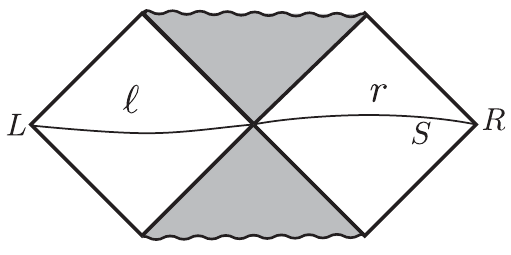
Figure 4 . The Penrose diagram of the maximally extended asymptotically flat Schwarzschild spacetime. The left and right exteriors are the unshaded regions labeled ‘ and r ; the left and right regions at spatial infinity are labeled L and R . The shaded regions are behind past and future horizons. S is a bulk Cauchy hypersurface, chosen so that it can be decomposed as a union of portions in regions ‘ and r